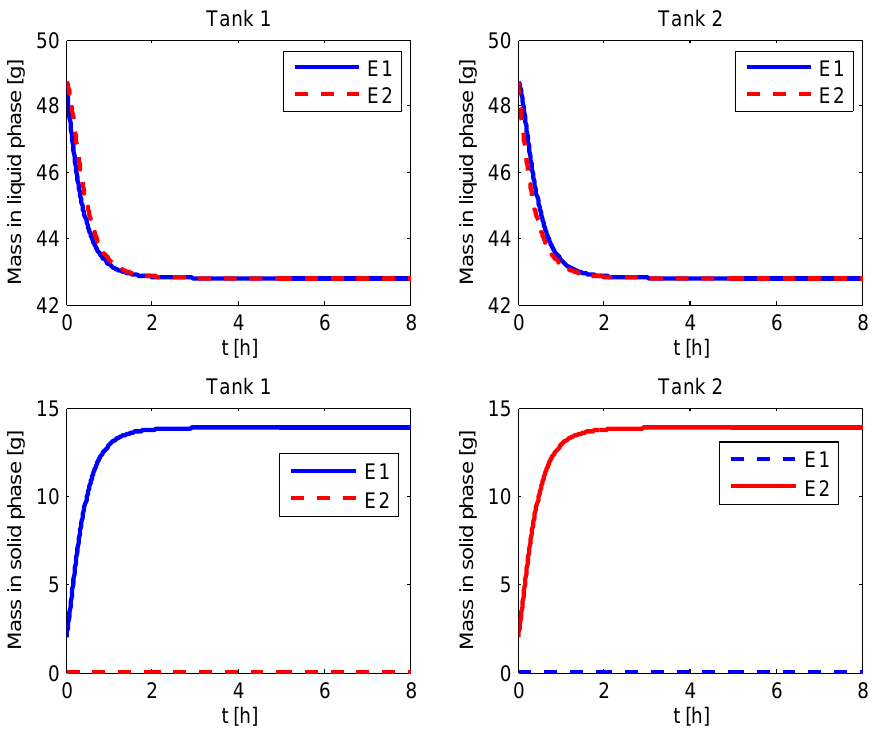
Figure 3. Evolution of mass in liquid and solid phases for the coupled preferential crystallization (CPC) configuration.